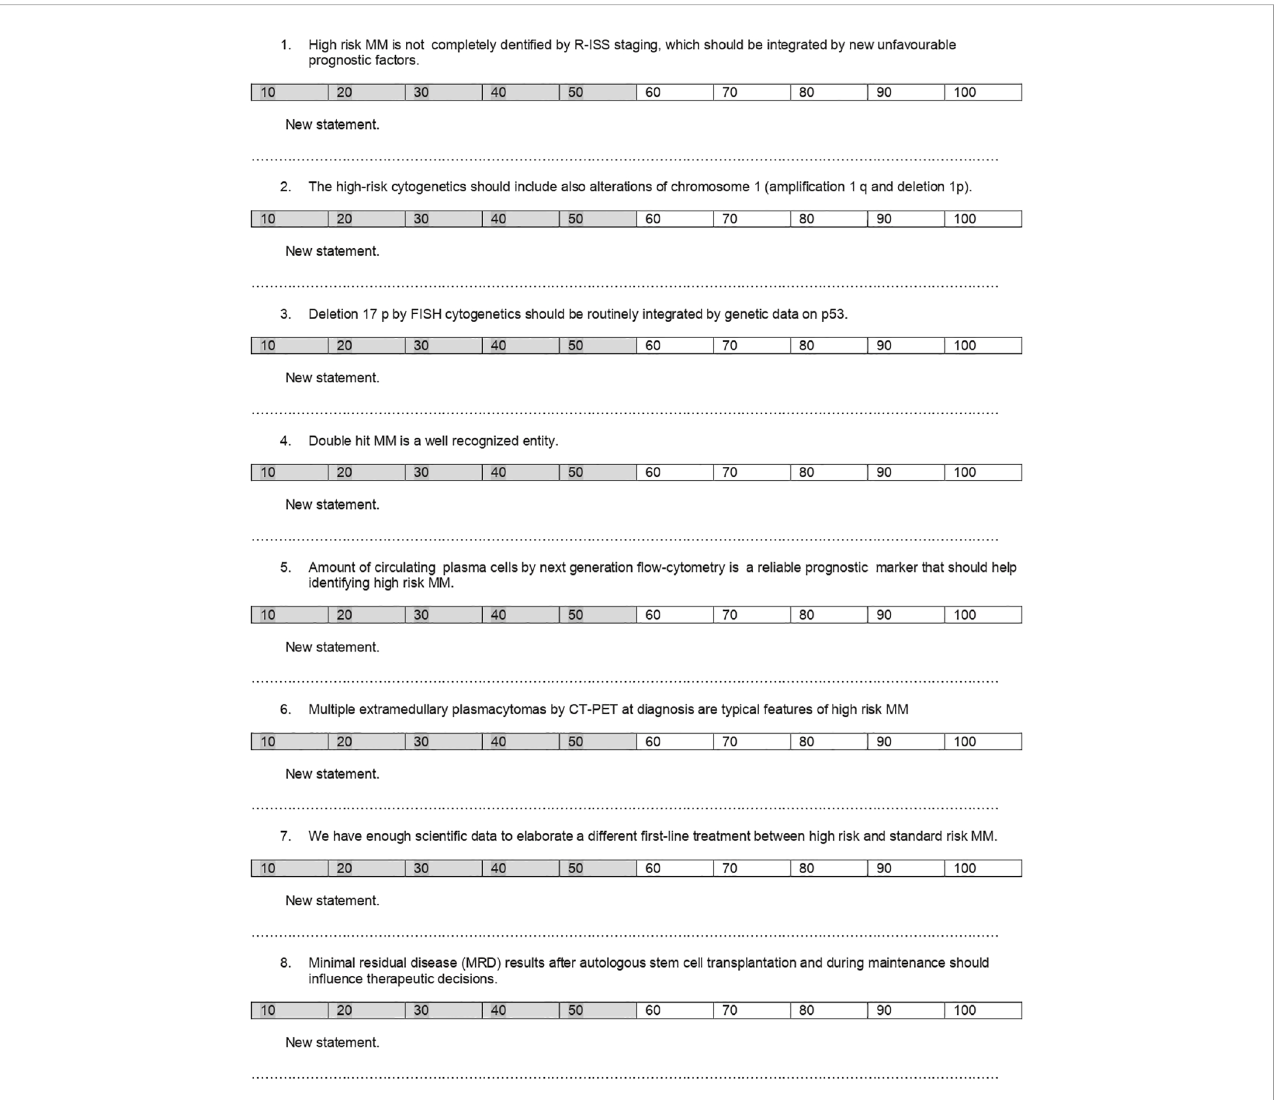
FIGURE 2 Delphi